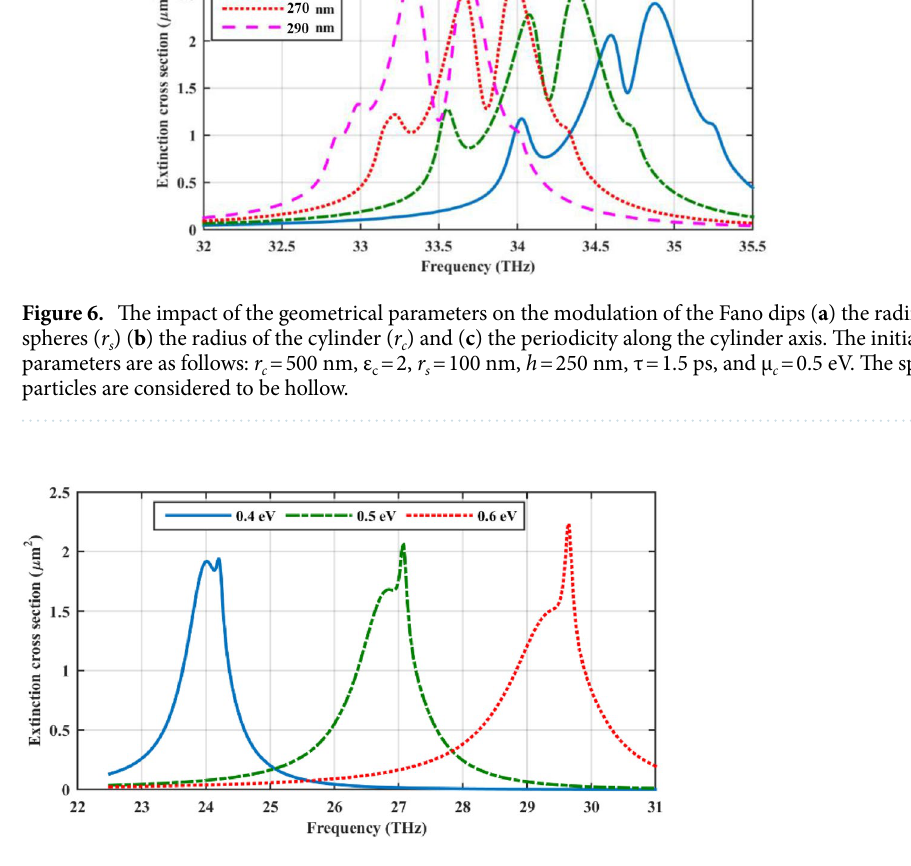
Figure 7. Impact of the polarization of the incident wave on the extinction cross-section of the dielectric cylinder coated with six one-dimensional periodic arrays. TM polarized plane wave is considered in this case. The initial design parameters are as follows: r c = 500 nm, ε c = 2, r s = 100 nm, h = 250 nm, τ = 1.5 ps, and μ c = 0.5 eV. The spherical particles are considered